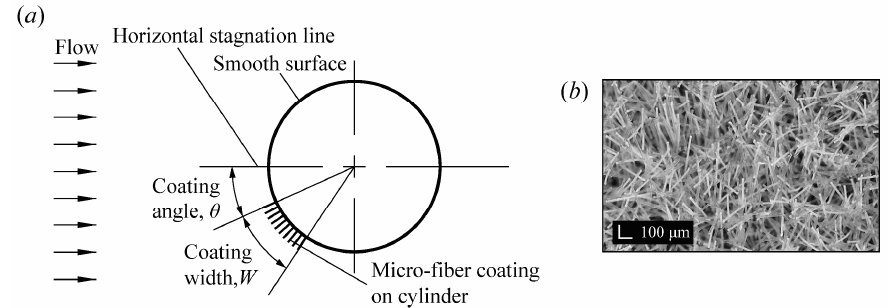
Figure 2. A schematic of a microfiber coating over the cylinder model: ( a ) Coating configuration on the cylinder model; ( b ) A microscope image of fabricated microfiber coating seen from the top.